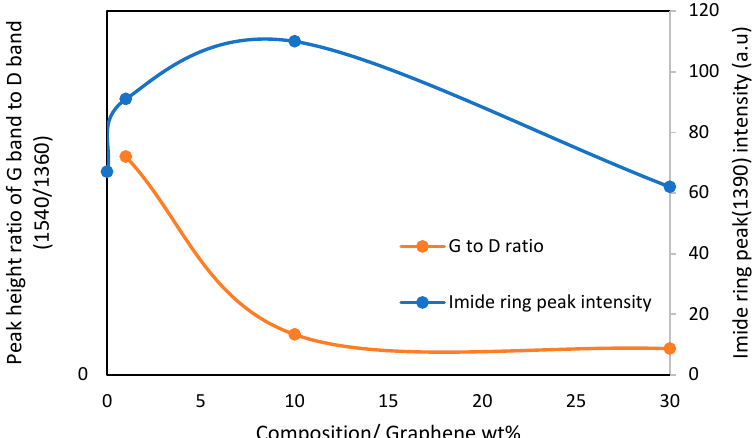
Figure 5. Dependence of the FT Raman imide ring peak intensity (1390 cm − 1 ) and ratio of peak intensity of G band to D band on graphene wt.% [87].